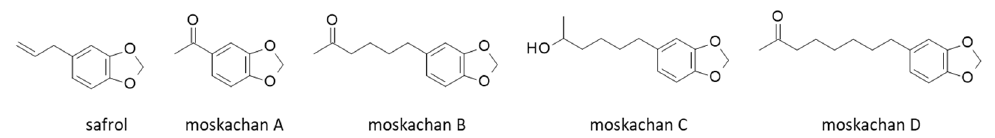
Figure 9. Structure of benzodioxone derivatives found in R. angustifolia Pers.